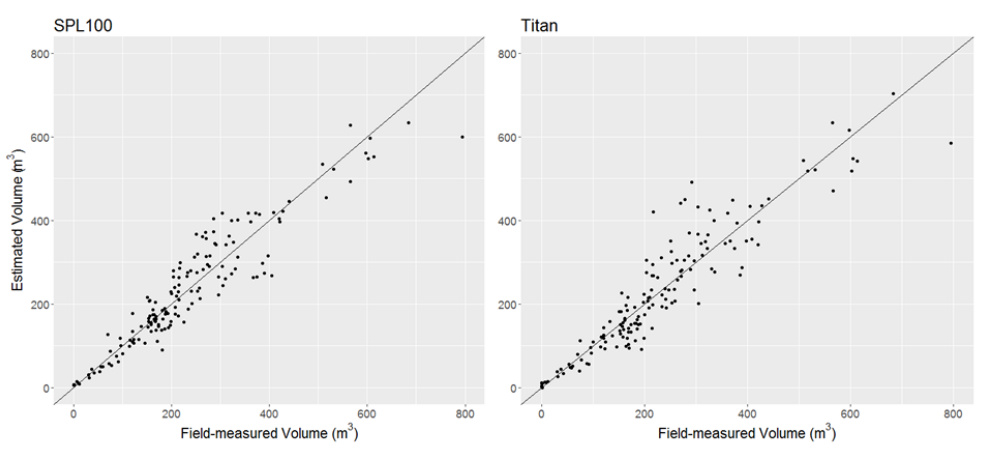
Figure 4. The plots shows estimated stem volume against field-measured stem volume (m 3 ). The left plot is for the SPL100 data and the right is for the Titan data.